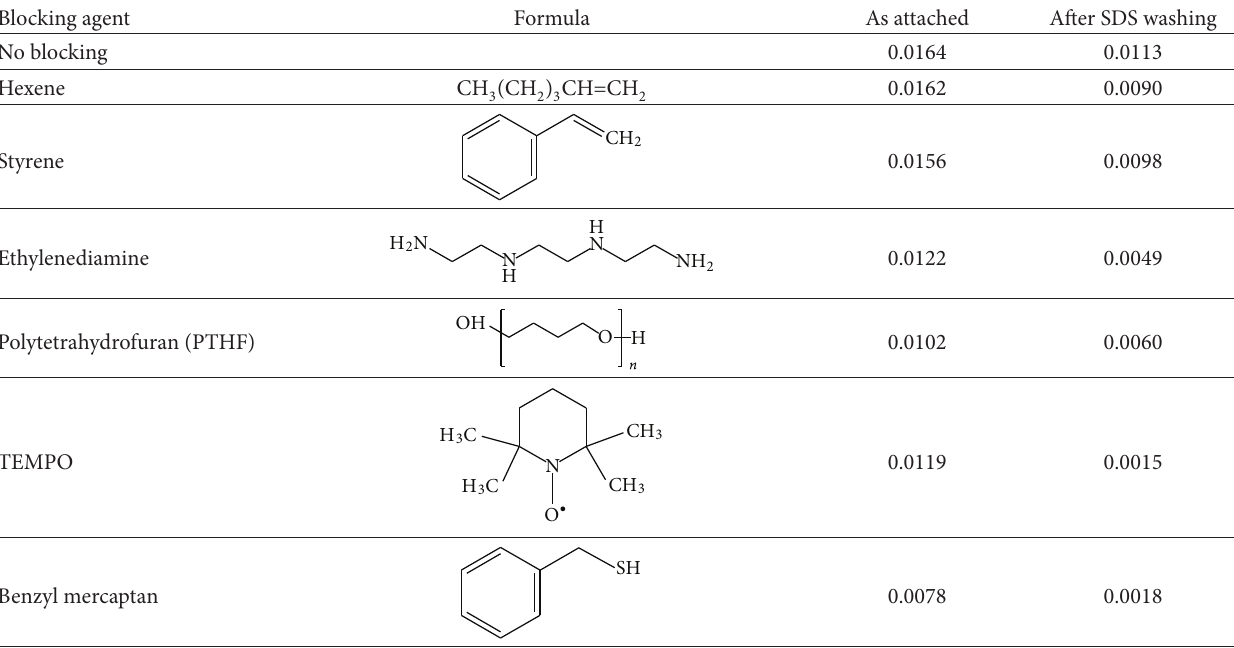
T 5: Amount of attached HRP protein (see (5)) on PIII-treated UHMWPE with various blocking agents of the surface. Detergent